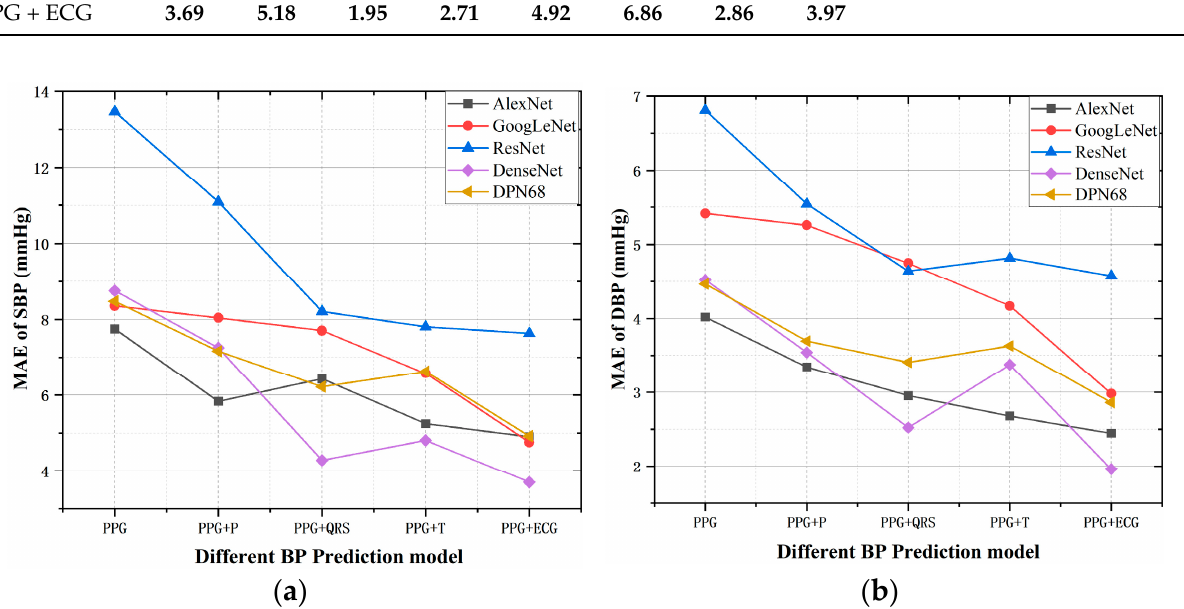
Figure 3. Estimation errors of five models with different input signal combinations. ( a ) MAE of SBP ( b ) MAE of DBP.